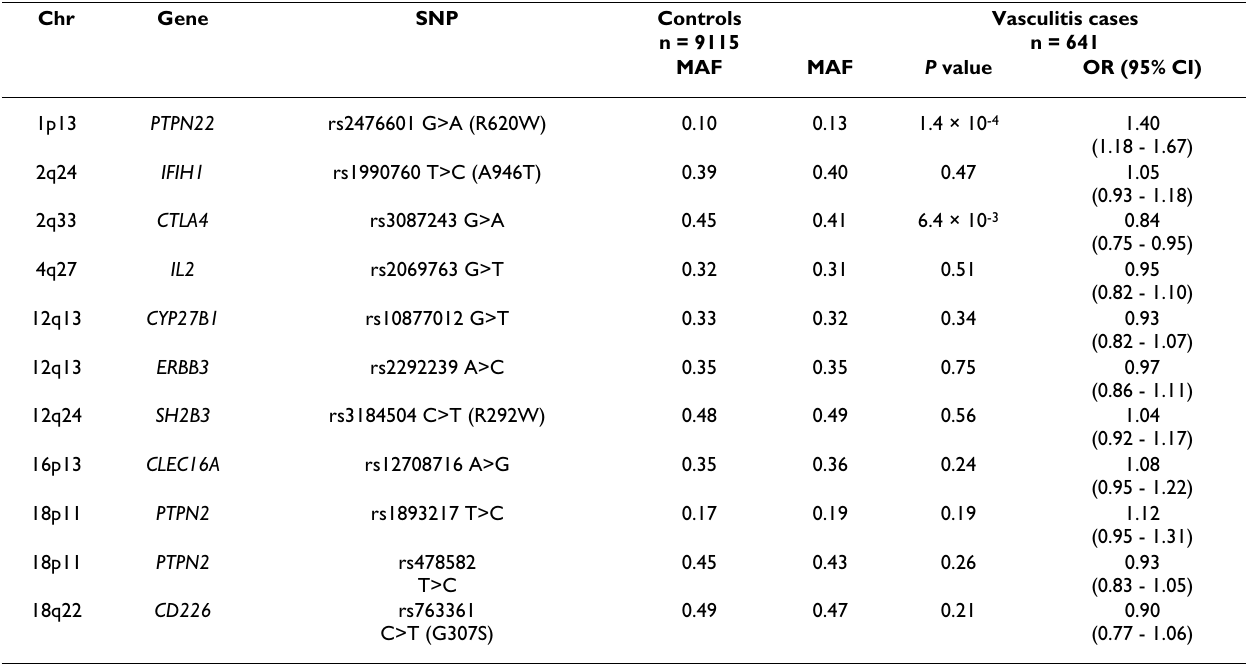
Table 1: Allele association testing in AAV of 11 SNPs at 10 loci Chr Gene